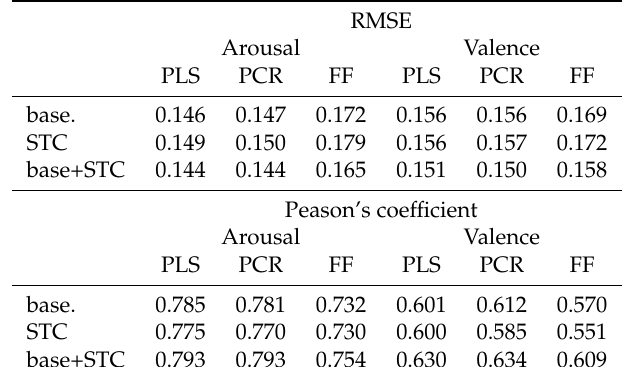
Table 2. Regression prediction results using the baseline features, sinusoidal transform coding (STC)-based features, and the combined features. The three regression models used are principal